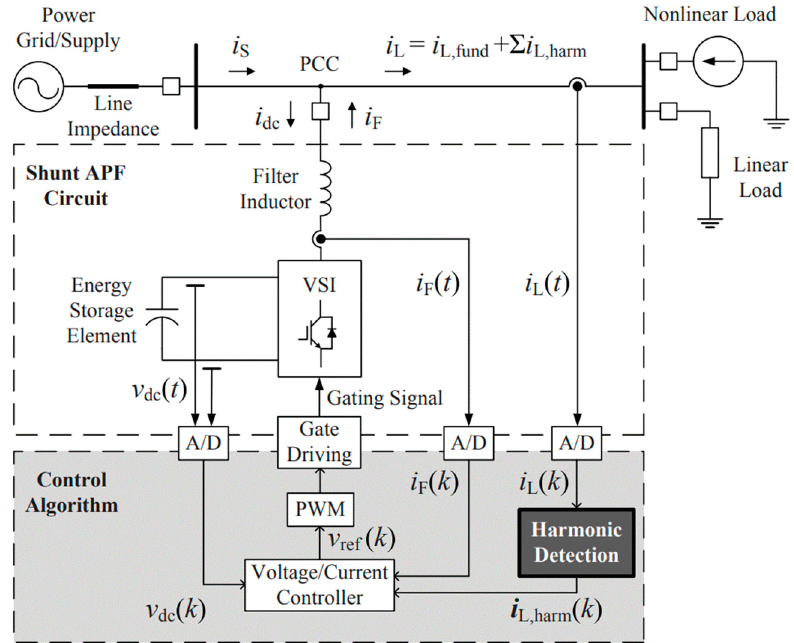
Figure 1. Shunt adaptive power filter (SAPF) in three-phase power supply.